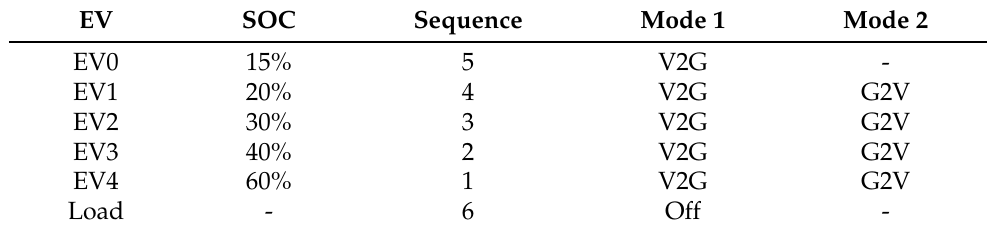
Table 2. Illustration of the EVs SOC and states [21], © 2021 IEEE.